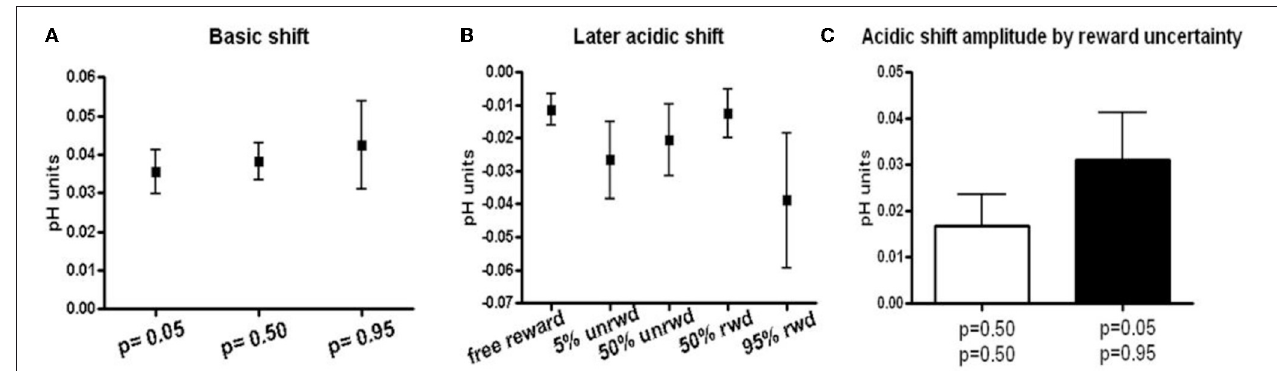
(middle), and average color plot representation of the response in about 90% of the recording locations. (C) Cyclic voltammogram (top, inset), current vs time (middle), and color plot of a dopamine-like signal in the residual after accounting for pH with principal component analysis.